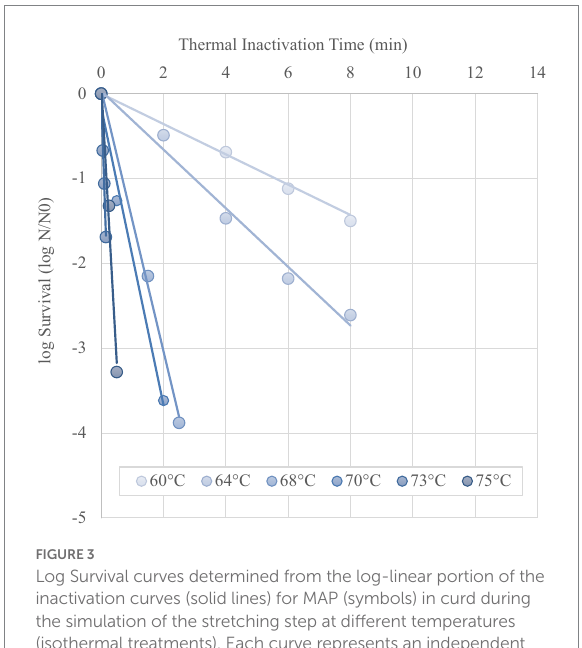
FIGURE 3 Log Survival curves determined from the log-linear portion of the inactivation curves (solid lines) for MAP (symbols) in curd during the simulation of the stretching step at different temperatures (isothermal treatments). Each curve represents an independent experiment.